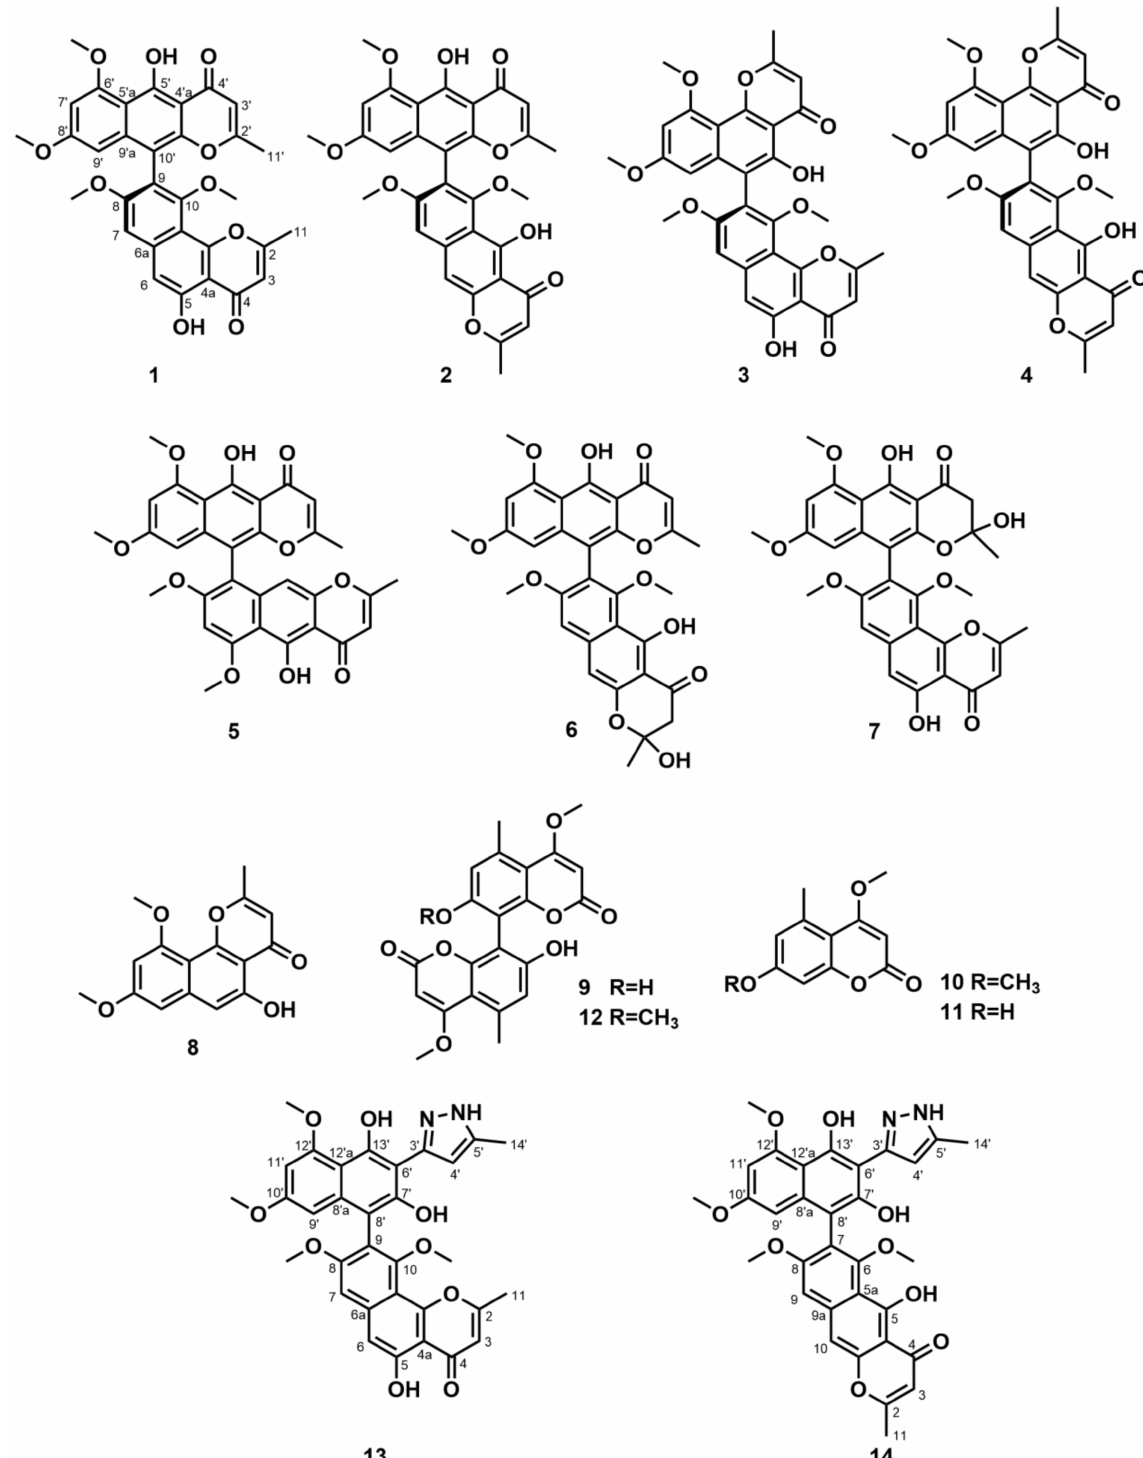
Figure 1. Structures of compounds 1 – 14